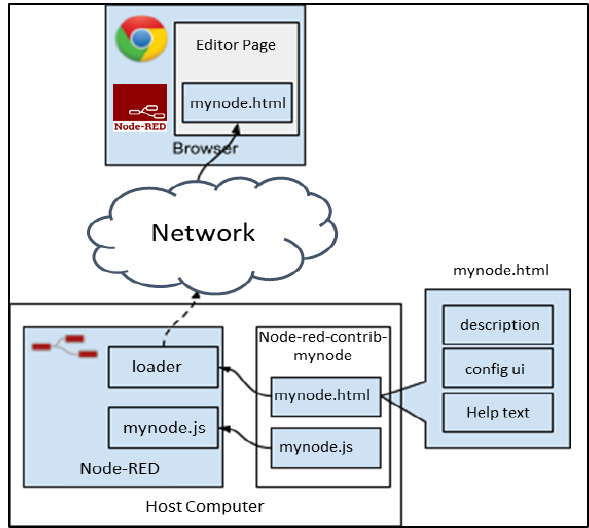
Figure 23. System Architecture for Node-RED API.